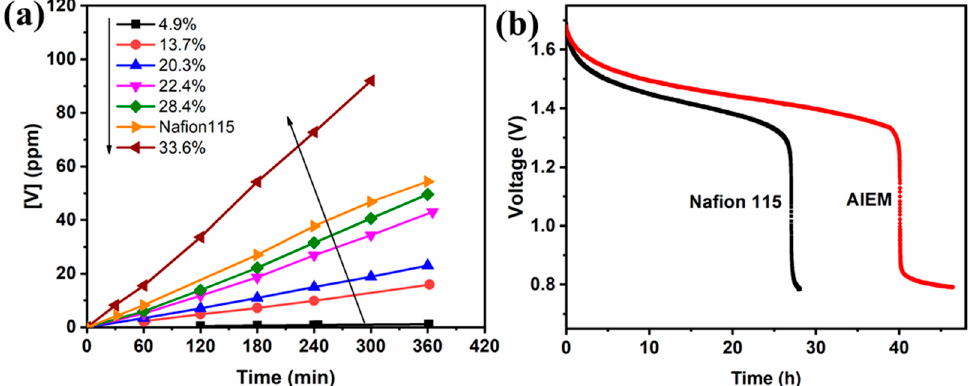
Figure 8. ( a ) Permeability of VO 2 + ions and ( b ) open circuit voltage of the vanadium redox flow battery (VRFB) assembled with Nafion 115 and the AIEM (GY = 28.4%).